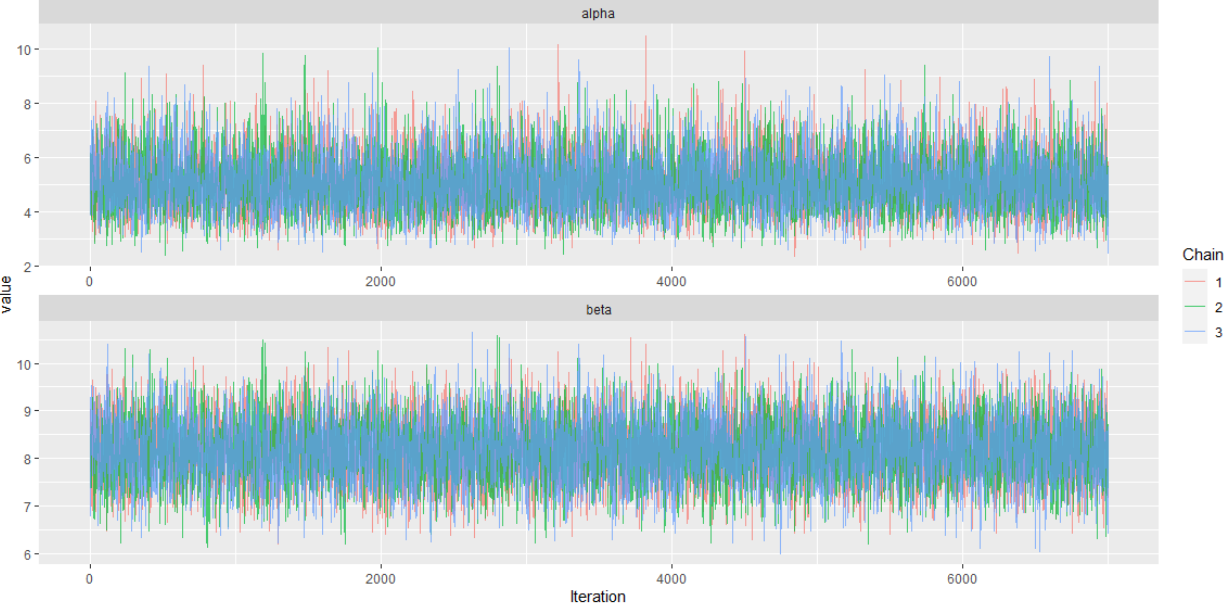
Figure 11. The AP distribution posterior parameters trace plots. The ergodic mean plots (Figure 12) of the parameters clearly show that the chains have converged after 3000 iterations.